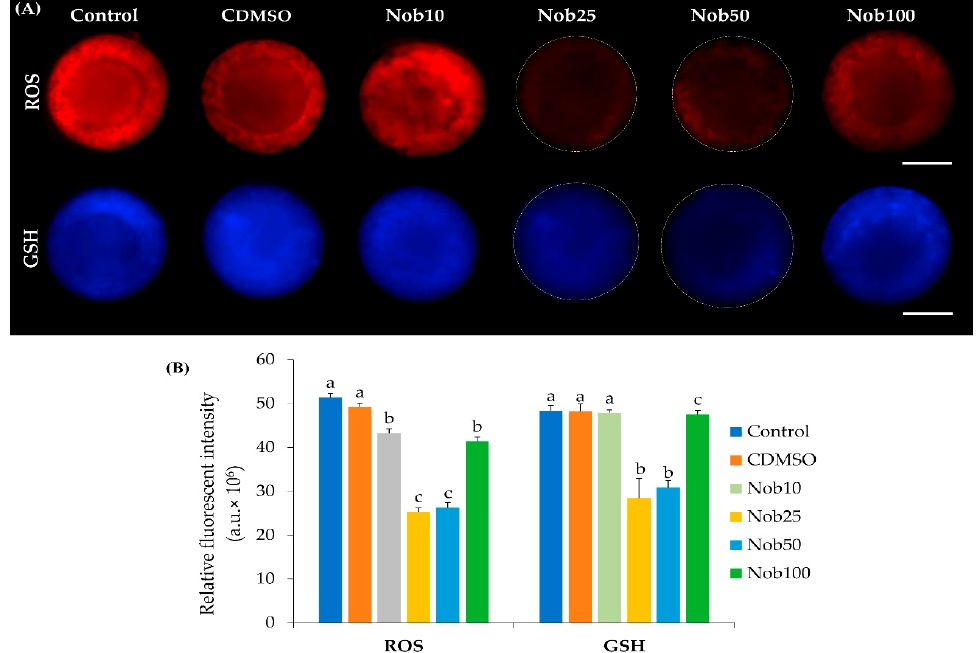
Figure 3. Reactive oxygen species (ROS) and glutathione (GSH) fluorescence intensity in bovine oocytes after in vitro maturation in the presence of nobiletin ( A ) Representative fluorescent images of ROS and GSH fluorescence intensity in bovine oocytes after in vitro maturation in the presence of nobiletin. Control ( n = 54); C DMSO ( n = 48); Nob10 ( n = 50); Nob25 ( n = 47); Nob50 ( n = 53); Nob100 ( n = 49). ( B ) Quantification of relative fluorescent intensity of ROS and GSH in bovine oocytes after in vitro maturation in the presence of nobiletin. Data are the mean ± SEM. Values with di ff erent superscript letters di ff er significantly ( p < 0.05). Scale bar 50 µ